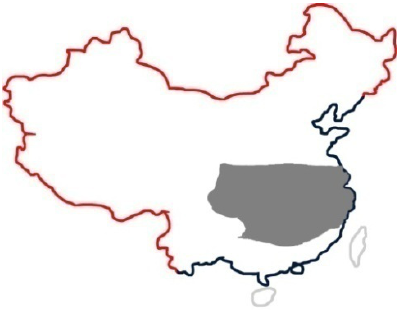
Figure 26. Hot summer and cold winter region